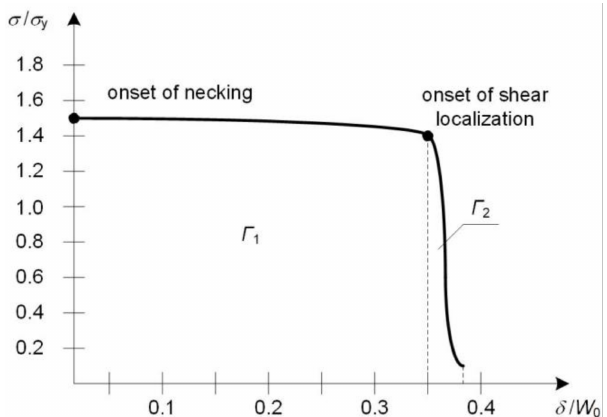
Figure 7. Methodology of cohesive energy determination, data from